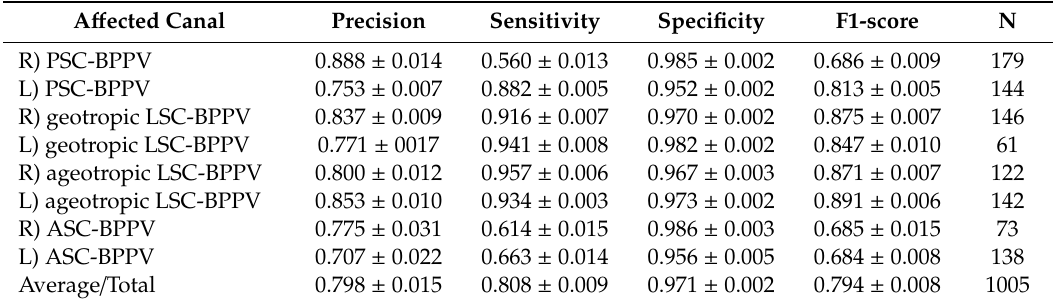
Table 1. Model sensitivity and specificity in diagnosing types of benign paroxysmal positional vertigo (BPPV) after 10-fold cross-validation using nystagmus videos of 1005